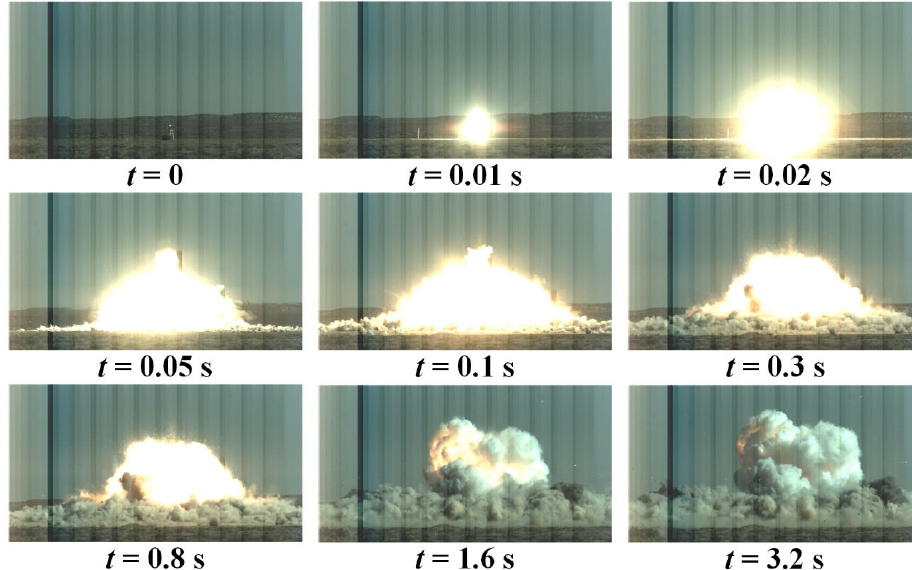
Figure 2. Explosion experiment process of energetic material.